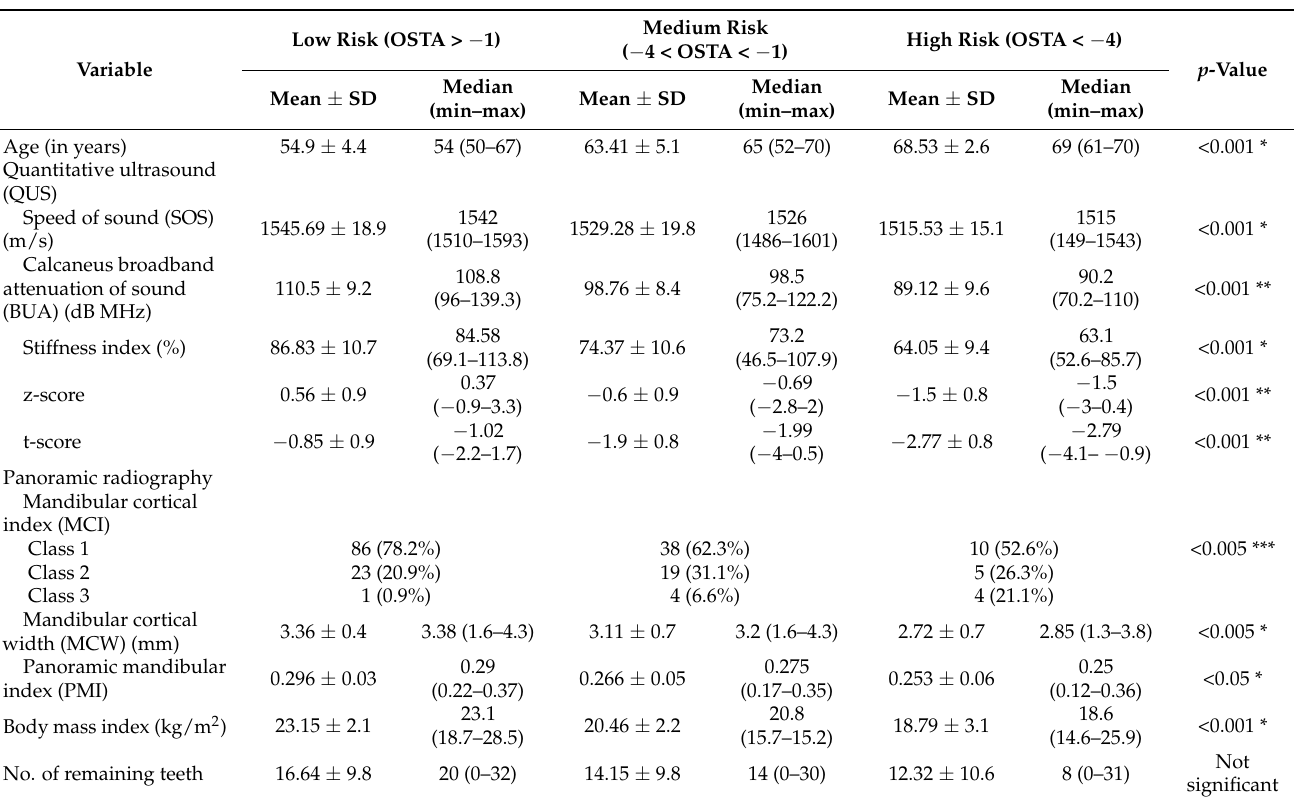
Table 2. Per QUS, the OSTA index significantly decreased in its SOS, BUA, and SI values. On the high-risk OSTA index, the z-score was in the osteopenia category. On the moderate- and high-risk OSTA indexes, the t-scores corresponded to osteopenia and osteoporosis. Table 2. The relationships of the Osteoporosis Self-Assessment Tool for Asians (OSTA) with all of the variables in